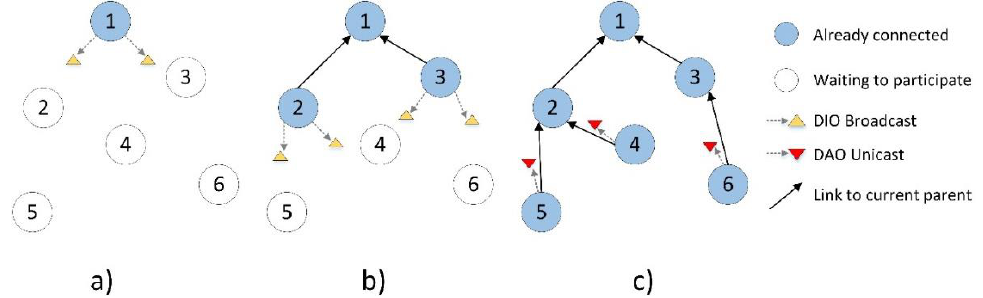
Figure 2. The exchange of Routing Protocol for Low-Power and Lossy Networks (RPL) control messages to build the topology. DIO, Destination-Oriented Directed Acyclic Graph (DODAG) Information Object; DAO, Destination Advertisement Object. ( a ) Sink node starts the dissemination of the RPL information with DIO messages; ( b ) Connected nodes forward the information downwards; ( c ) Connected nodes send upwards a DAO message.